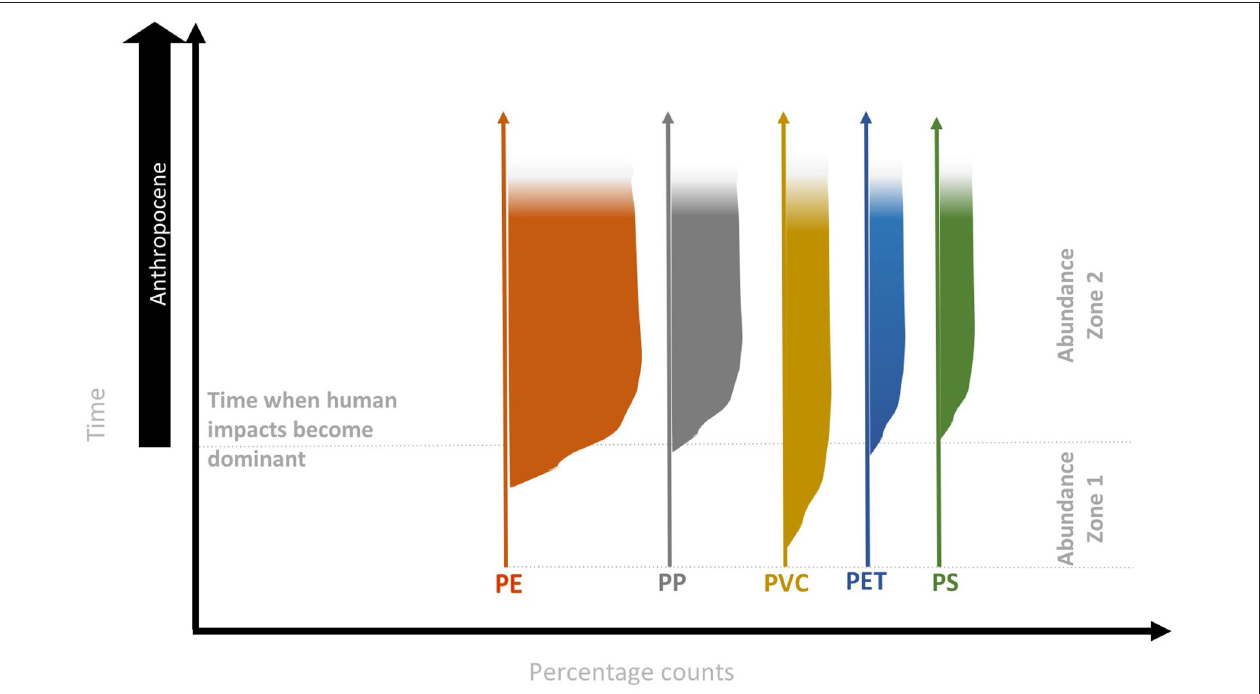
FIGURE 3 | Microplastic potential abundance zones and their utility for defining the Anthropocene. Abundant zones are based on the relative percentages of individual polymer species (herein represented by production rates of PE, PP, PVC, PE, and PS) and can potentially be used to characterize the Anthropocene strata. Original figures and complete discussion on the biostratigraphy of the Anthropocene are published in Barnosky (2014).